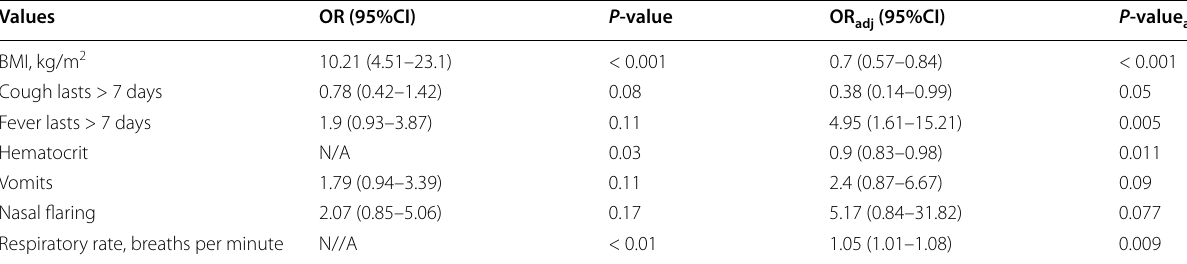
CI Confidence intervals, OR Odds ratio, OR adj Adjusted odds ratio